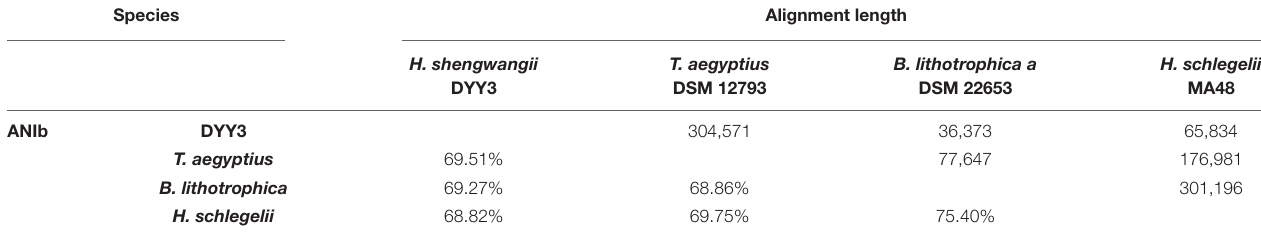
TABLE 5 | The ANIb values and alignment length of strain DYY3 and species in family